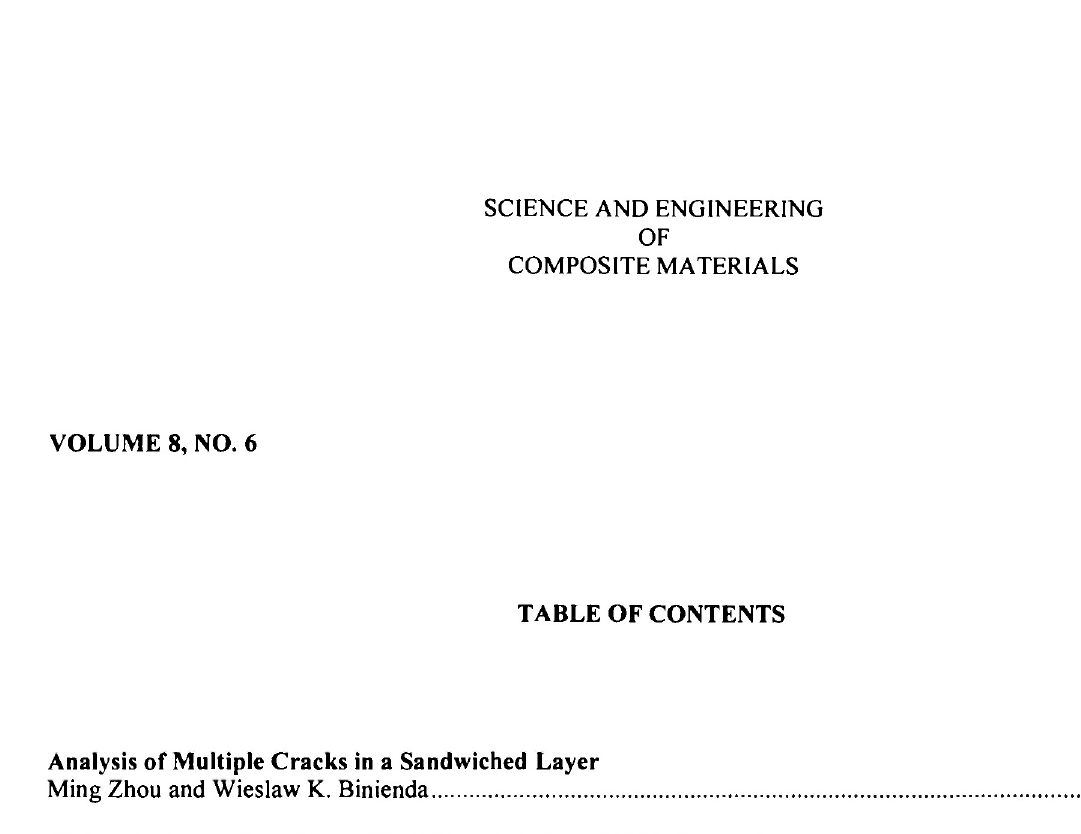
Analysis of Multiple Cracks in a Sandwiched Layer Ming Zhou and Wieslaw K.